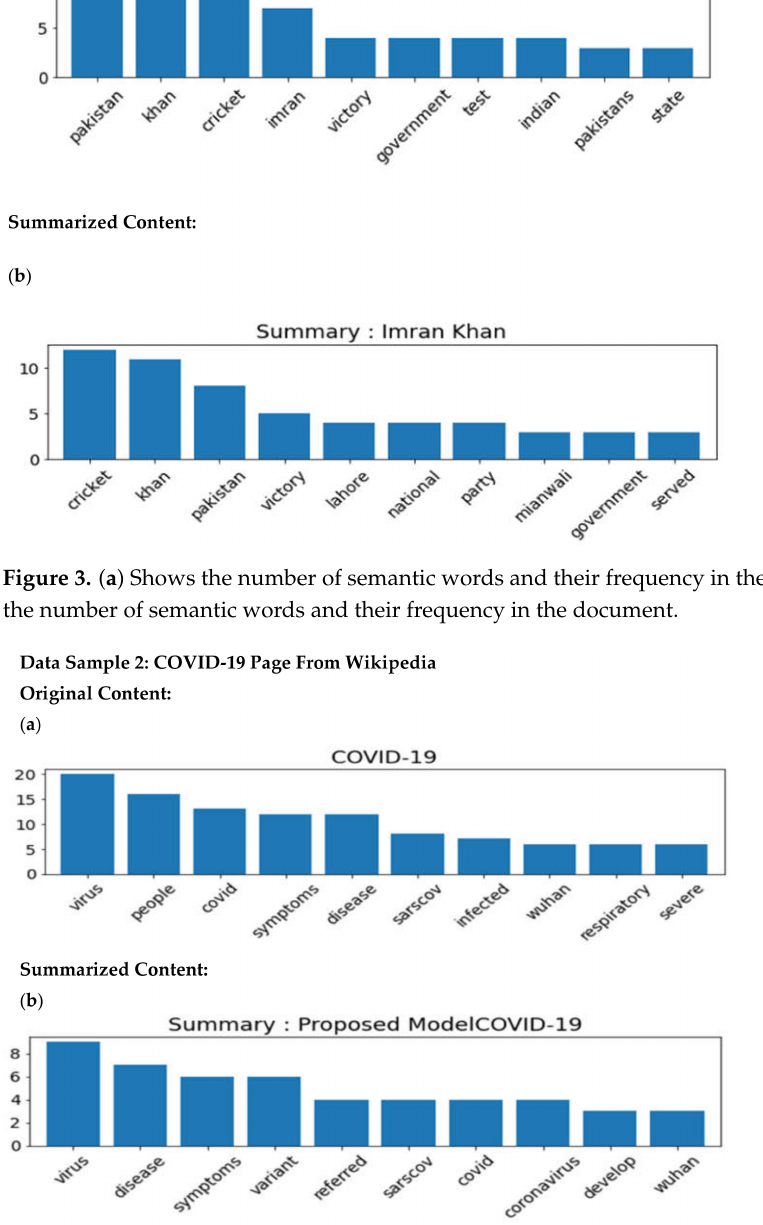
Figure 4. ( a ) Shows the number of semantic words and their frequency in the document. ( b ) Shows the number of semantic words and their frequency in the